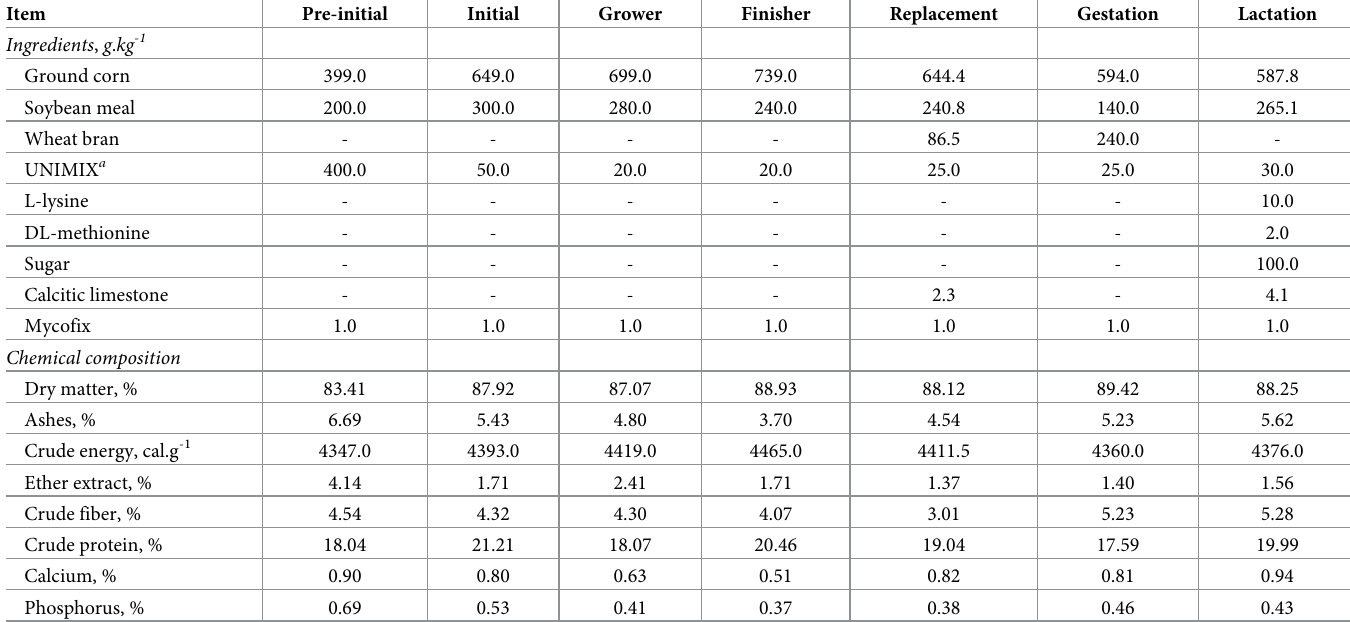
Table 1. Composition of pre-initial, initial, growth and termination diets, specific to each physiological phase of swine